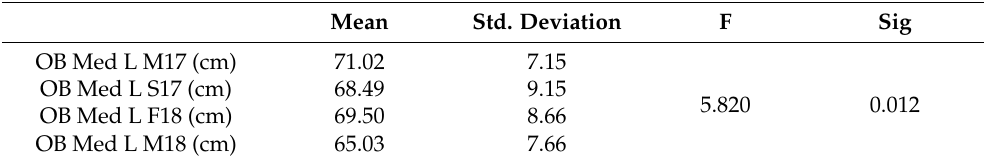
Table 3. OB values in the medial direction of the left